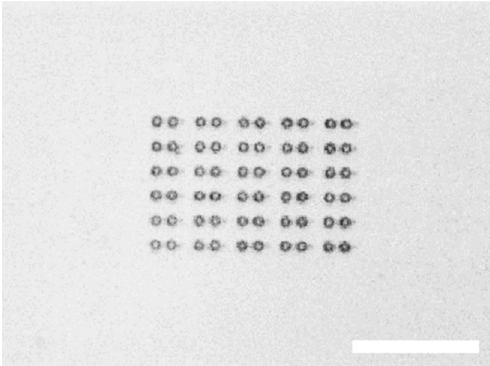
Figure 3. Optical microscope photograph of an array of 30 micro-tools printed on a glass substrate (microscope coverslip). Printing the entire matrix of micro-tools makes it easier to locate the tools on the glass slide after they are detached and float in a water-filled chamber. Scale bar: 100 µm.